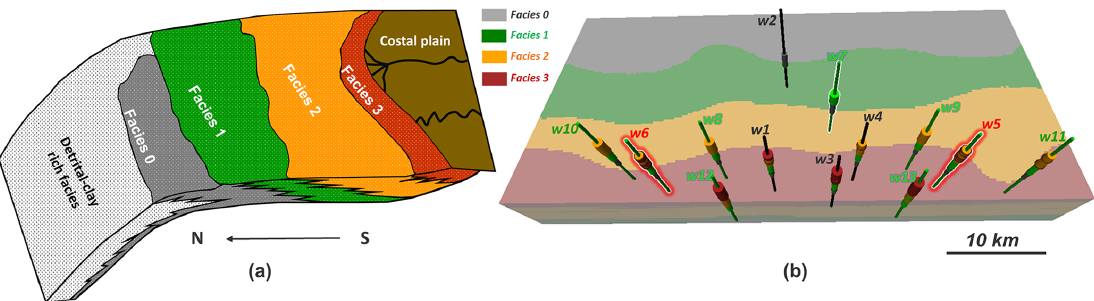
Figure 5. (a) The field geology conceptual model with the four facies belts. (b) The initial 3-D geological model of facies with locations of existing boreholes and newly drilled boreholes.